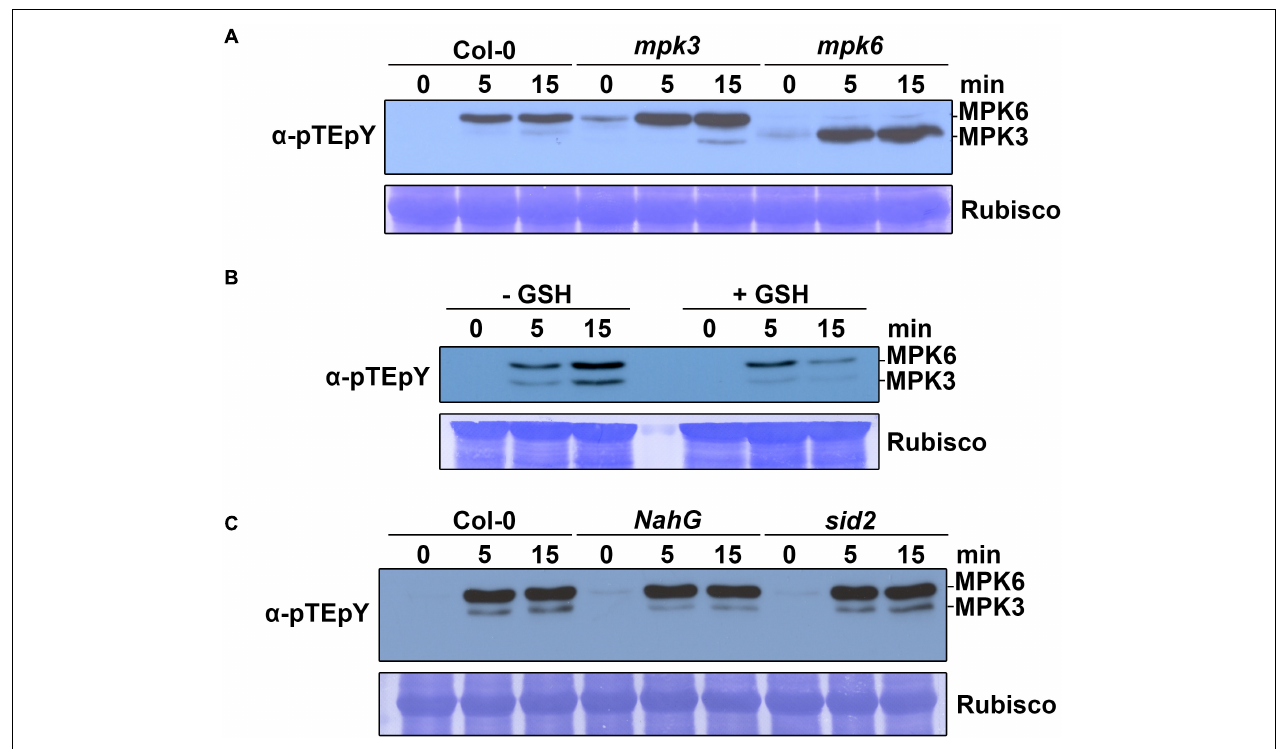
FIGURE 6 | Naringenin activates MPK3 and MPK6. (A) Activation of MAPK by naringenin. Two-week-old Col-0, mpk3 and mpk6 plants were treated with 100 µ M naringenin. Samples were collected at 0, 5, and 15 min after treatment. Total protein extracts were prepared from those treated plants. MAPK activation was detected by immunoblotting with anti-p44/42 antibodies (Cell Signaling Technology, United States). Input was visualized by Rubisco. The experiment was performed three times with similar results. (B) ROS-dependent activation of MAPK by naringenin. Two-week-old Col-0 plants were pretreated for 1 h with or without 200 µ M GSH and subsequently treated with 100 µ M naringenin and then analyzed as detailed in above. (C) SA-independent activation of MAPK by naringenin. Two-week-old Col-0, NahG and sid2 plants were treated with 100 µ M naringenin and then analyzed as detailed in above. The experiment was repeated three times with similar results.